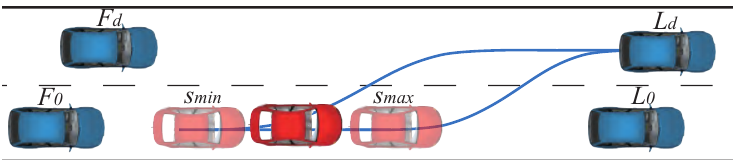
Figure 7. The minimum and maximum longitudinal position for lane-change